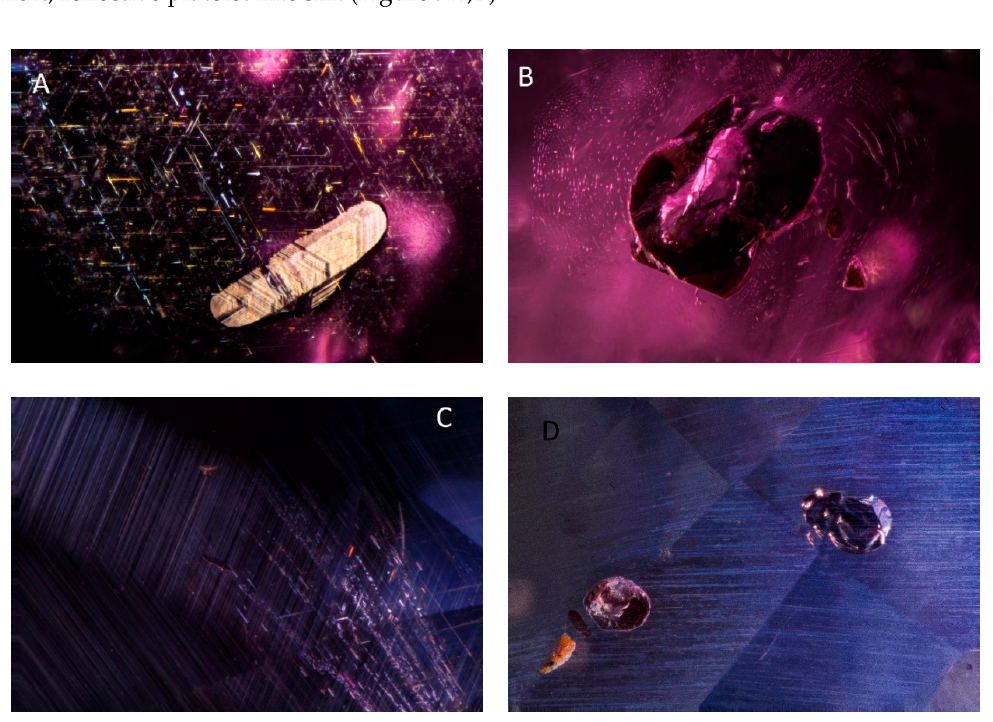
Figure 9. Photomicrographs of typical inclusions in Sri Lankan ( A , B ) rubies representing ( A ) elongate negative crystals and reflective rutile silk and ( B ) a biotite inclusion and ( C , D ) blue sapphire representing ( C ) elongate and reflective rutile silk and ( D ) biotite inclusions. Photomicrographs by Aaron C. Palke. Fields of view: ( A ) 1.26 mm, ( B ) 1.76 mm, ( C ) 1.47 mm, ( D ) 1.49 mm.